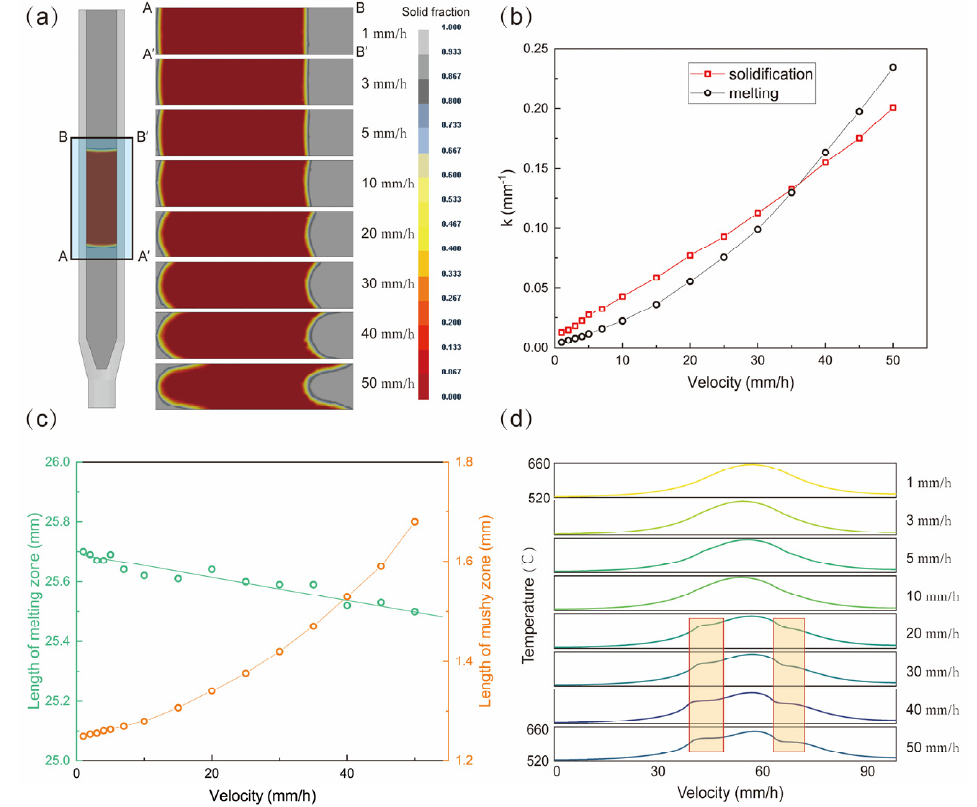
Figure 7. Influence of melting furnace moving velocity on melting zone characteristics and temperature distribution. ( a ) Morphology of melting zone under different melting temperatures, ( b ) curvature of solidification interface and melting interface, ( c ) length of melt zone and mushy zone, ( d ) temperature distribution at the center axis.